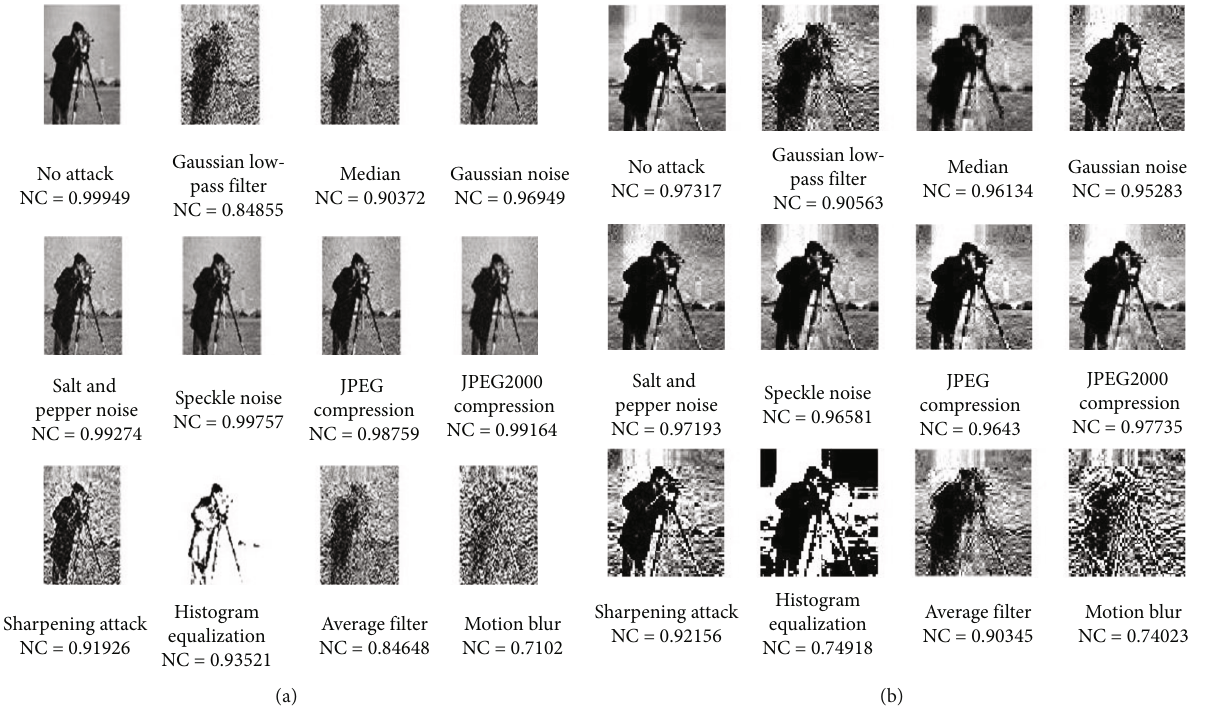
Figure 8: Watermarked images after applying di ff erent attack types: (a) lion image and b) Elaine image. Table 3: Performance of the DWT-SVD method to fi nd invisibility and quality of watermarked